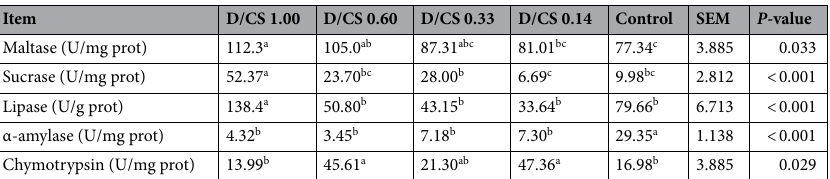
Table 6. The effects of NFD on the ileal digestive enzyme activity of broiler chickens. The enzyme activity of maltase and sucrase were detected in the mucous of ileum, and the enzyme activity of lipase, α-amylase, and chymotrypsin were detected in the digesta of ileum. Values are expressed as the mean and pooled SEM ( n = 6 per group). Different superscript letters in the same row mean significant differences ( P < 0.05).